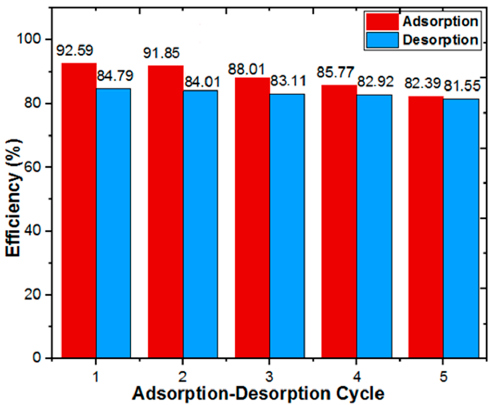
Figure 4. Adsorption–desorption cycle of MO C-ZnCl2 with alkaline solution NaOH (0.01 N).